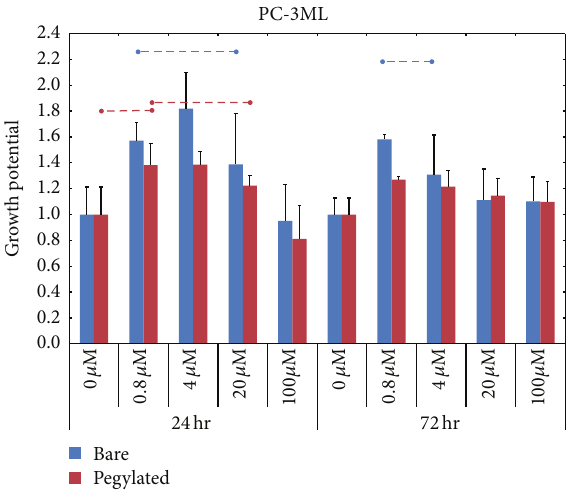
Figure 6: Proliferation of PC-3ML after treatment with bare and pegylated PHAuNPs. There was no significant change in cell proliferation after 72 hours of treatment for both types of PHAuNPs. MDAMB231